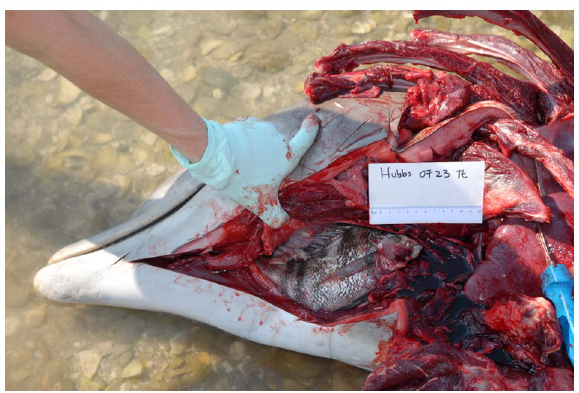
Figure 3. Photograph of dolphin with fish in esophagus. Photograph of IRL dolphin (Hubbs-1075) showing large fish displacing the laryngeal cartilage causing asphyxiation.